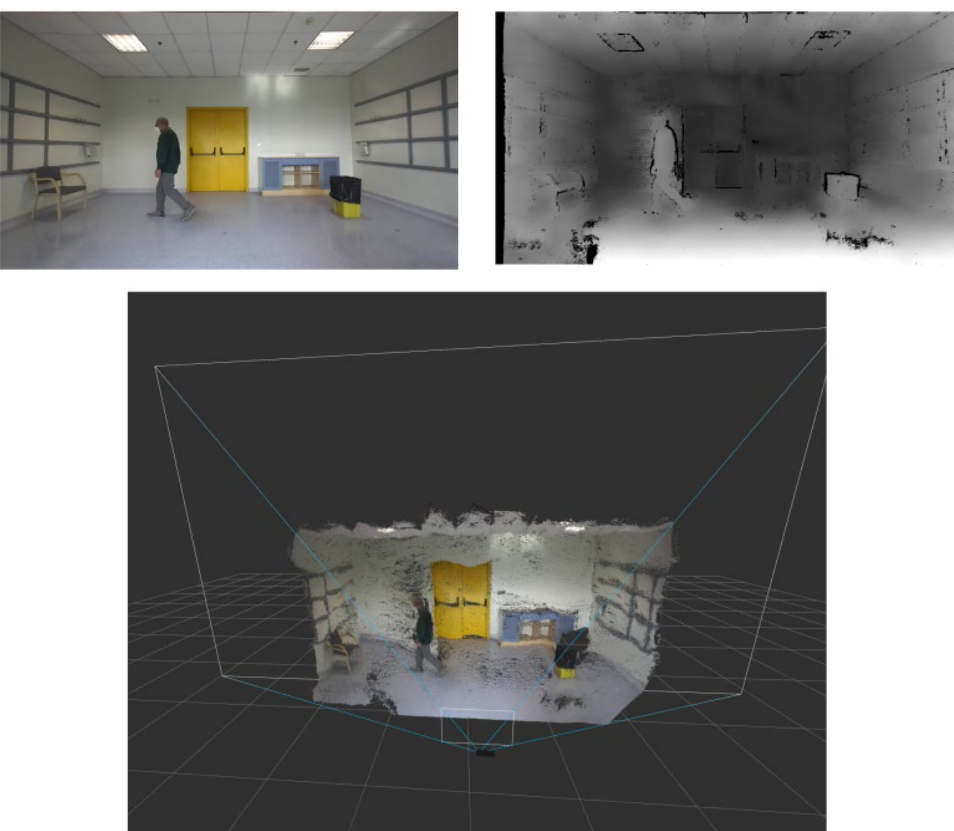
Figure 5. Test for assessing the subject’s gait skills. Top left image: input image. Top right image: the computed disparity map. Bottom image: how the system reconstructed the 3D scene where a subject was performing the test.